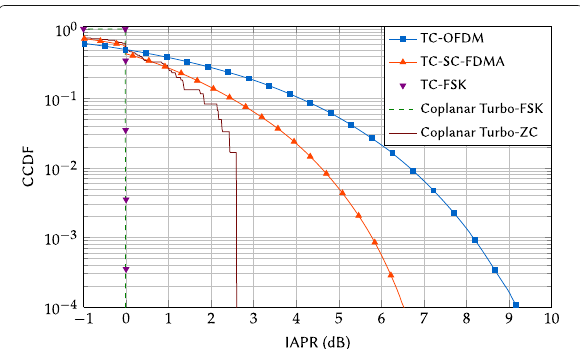
The Complementary Cumulative Distribution Function (CCDF) of the IAPR is depicted for the five schemes in Fig. 7. TC-OFDM has the largest variations and exhibits a probability of 10 − 3 to have an IAPR larger than 8 dB. TC-